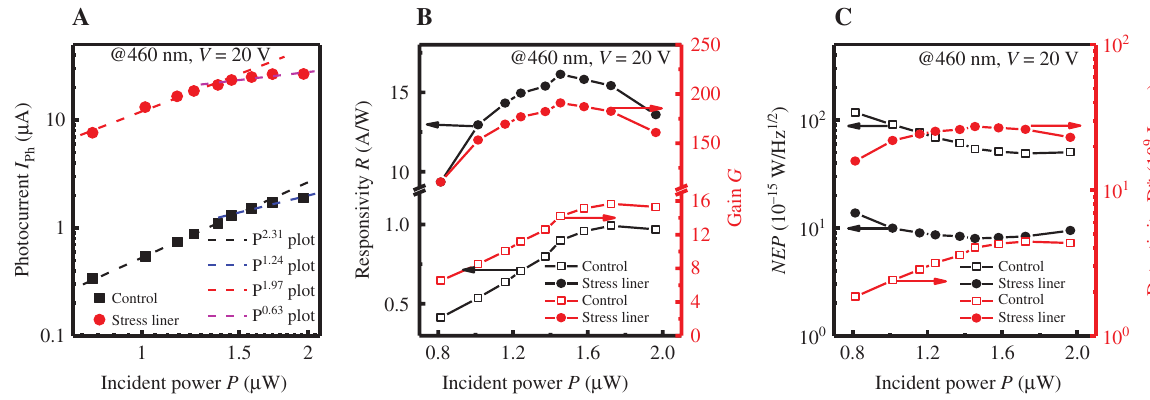
photodetectors with and without stress liner. 2